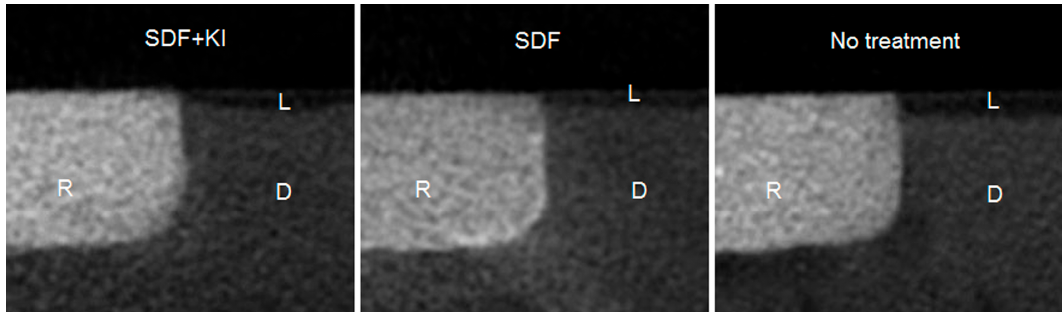
Figure 2. Micro-computed tomography (micro-CT) images of the three groups. SDF + KI: Group 1, the cavity was treated with silver diamine fluoride and potassium iodide; SDF: Group 2, the cavity was treated with silver diamine fluoride as positive control; No treatment: Group 3, negative control; R: glass ionomer cement (GIC) restoration; D: dentine; L: demineralised outer lesion.